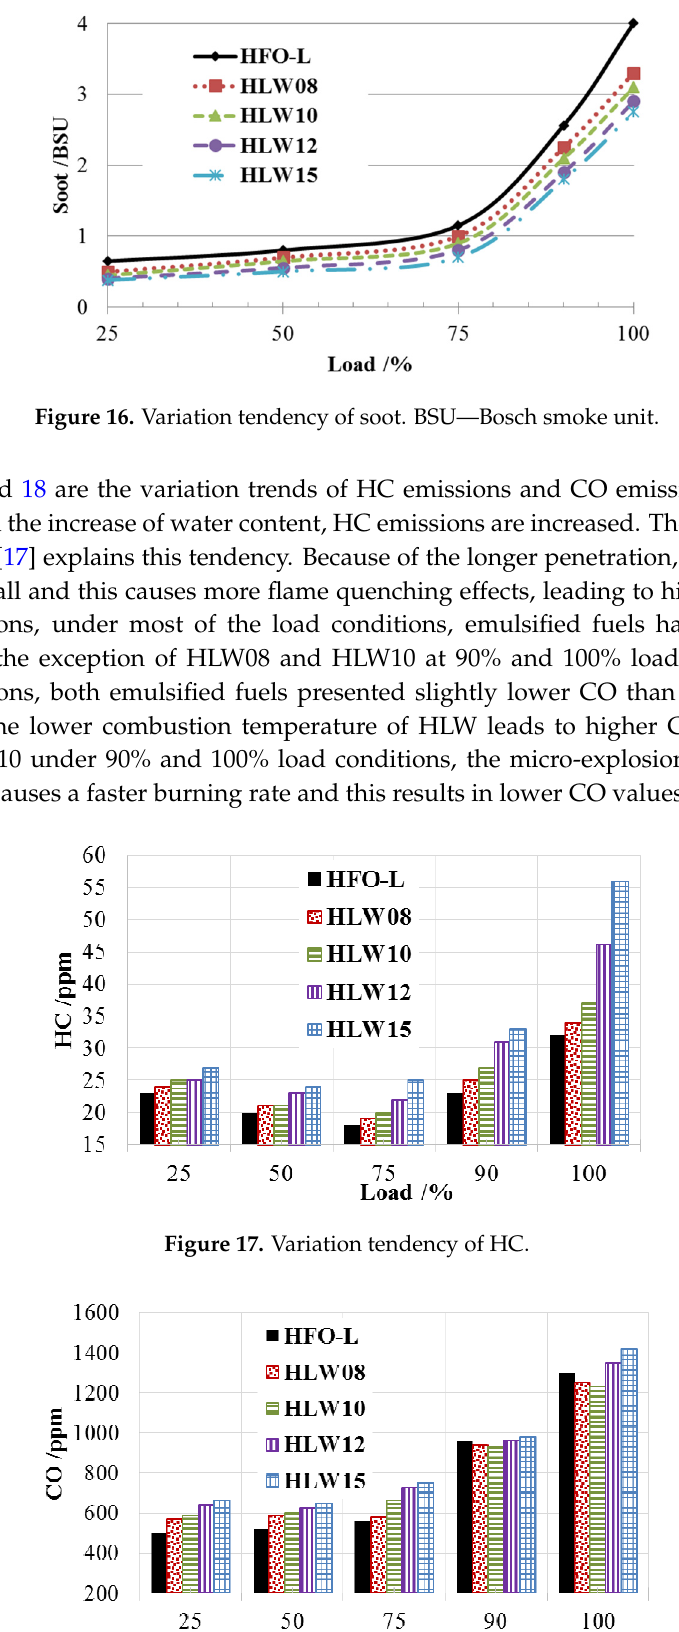
Figure 15. Variation tendency of NO x emissions.